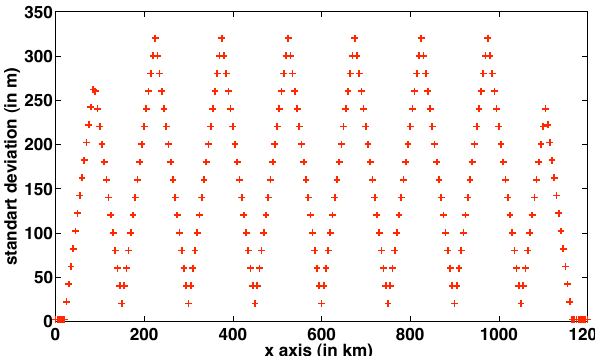
Fig. 7. Example of an initial ice sheet ensemble (50 members): bedrock topographies B soc (x) and surface elevation S(x) as func- tions of the horizontal distance x